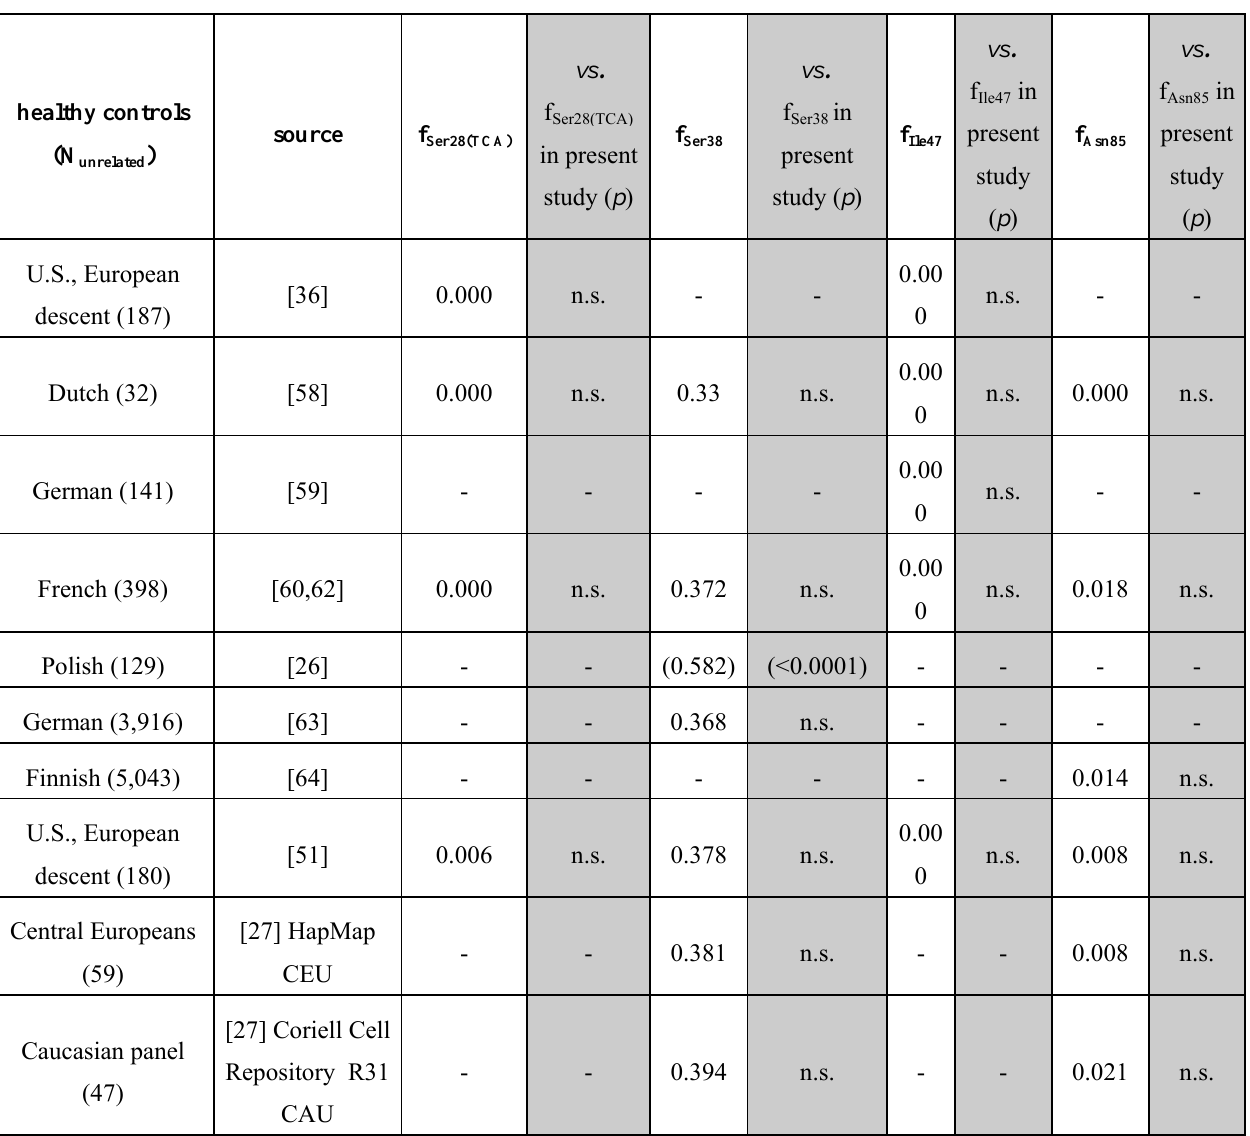
Table 2. Reference frequencies of KCNE1 coding variants in Caucasians as reported for unrelated, healthy controls. Of these, five control populations ([36,52,58-60], total N=938) have been systematically screened for mutations and serve as a reference for the novel V47I variant. One further study involving 100 Canadian controls [31] was excluded as allele frequencies were missing. Data reported by Prystupa et al. [26] are given in brackets to indicate a likely misallocation of major and minor alleles. When this figure is excluded, exact tests of allelic association conducted with reference populations and the tinnitus sample give non-significant (n.s.) results